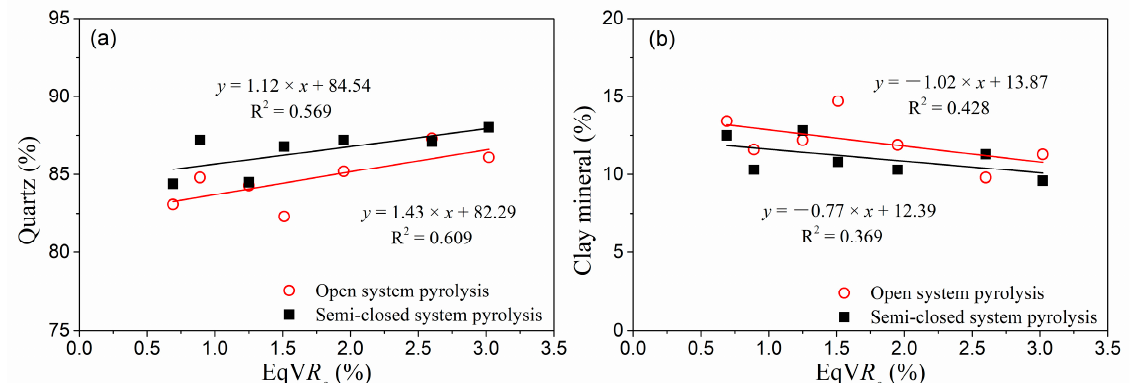
Figure 5. Changes of ( a ) quartz and ( b ) clay mineral content during thermal evolution of shale under two pyrolysis experiments Data of semi-closed pyrolysis are cited from Fang et al.